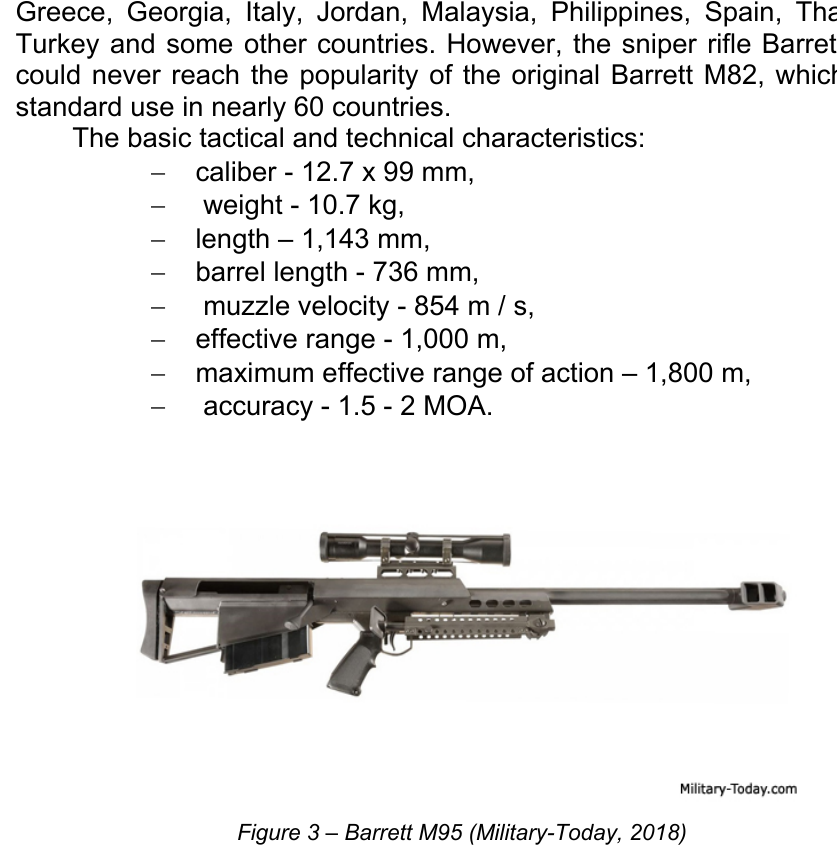
Figure 3 – Barrett M95 (Military-Today, 2018) Рис . 3 – Barrett M95 (Military-Today, 2018) Слика 3 – Barrett M95 (Military-Today,